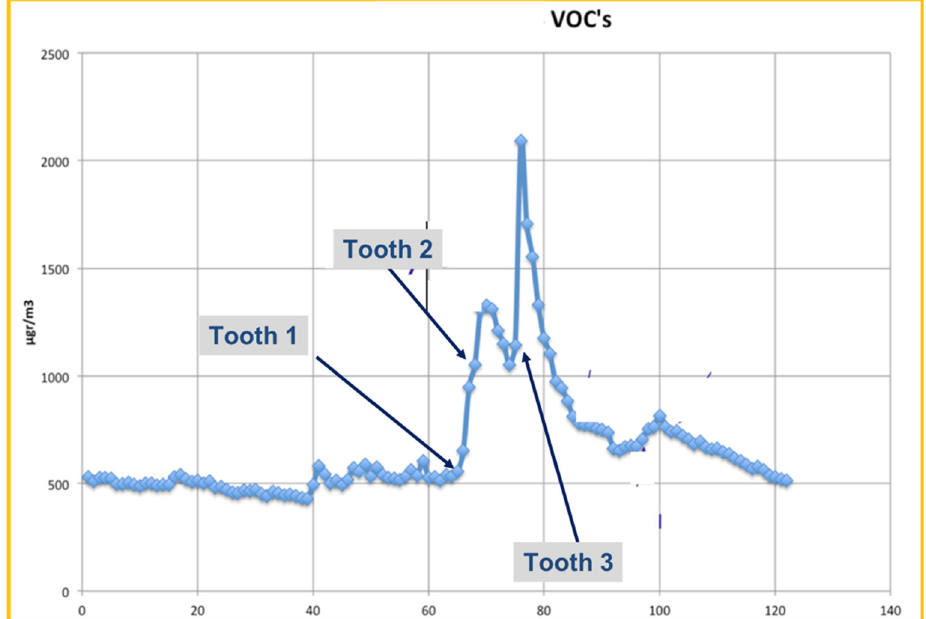
Figure 5. Recordings (over a 2-h span) of TVOCs on D11, during Laser operation. The arrows indicate the initiation of the laser device for cavity preparation, for each of the three teeth. No ventilation was taking place on that day. Take note of the hazardous values recorded.